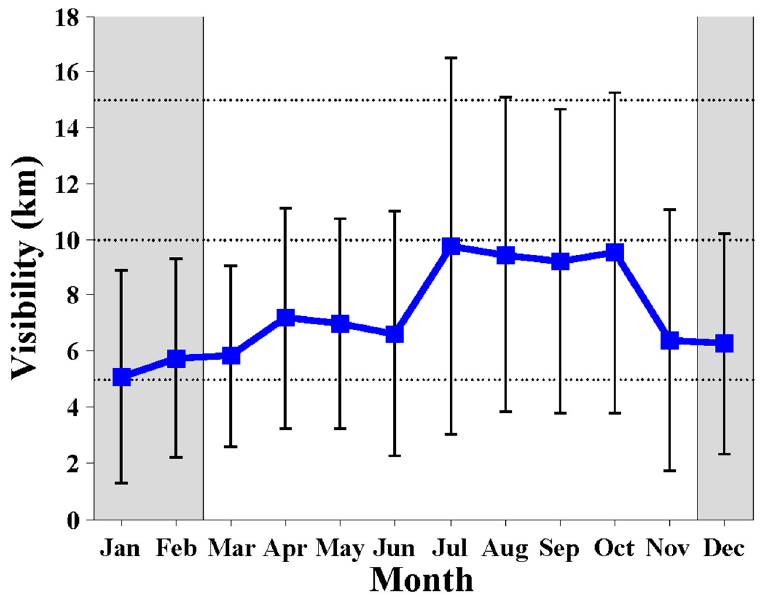
Figure 2. Monthly variations of atmospheric visibility in Nanjing averaged over 2013–2019. Error bars denote the standard deviations of daily visibility.